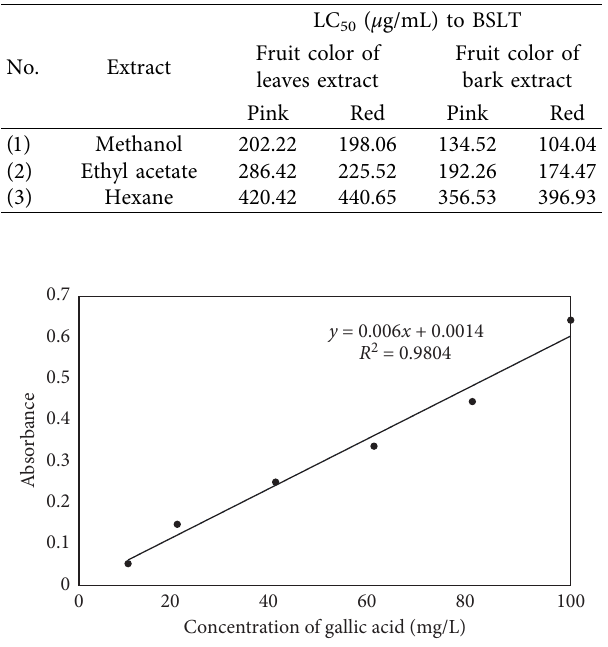
Figure 5: Calibration standard curve of gallic acid to determine total phenolic content.